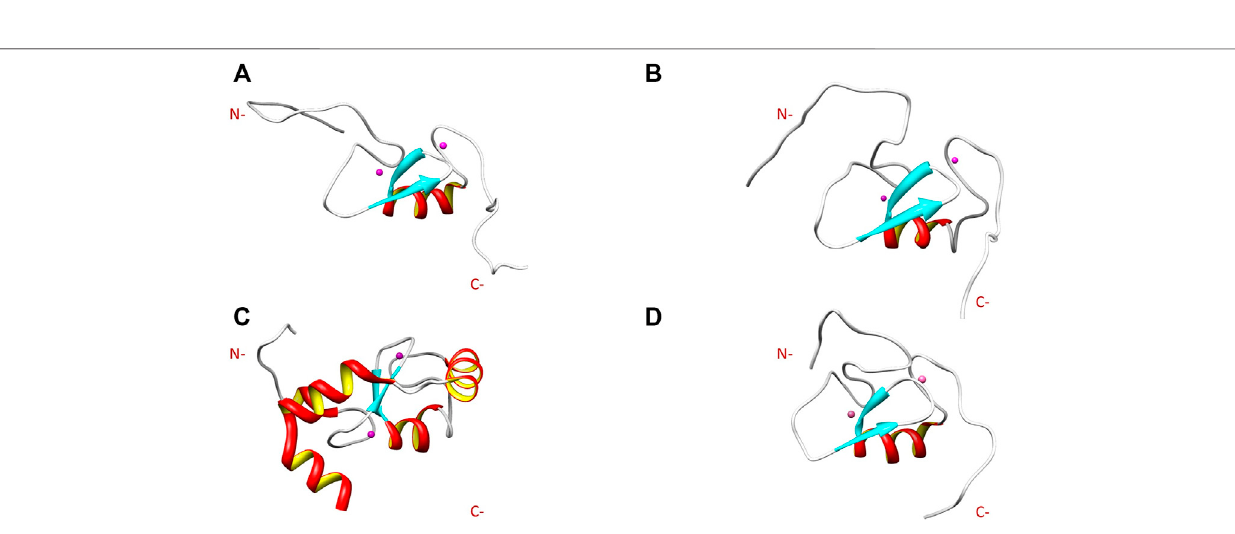
FIGURE 11 | NMR solution structure of (A) RNF24 (PDB: 2EP4), (B) R957C Arkadia, (C) RNF168 (PDB: 4GB0) and (D) wt Arkadia (PDB: 2KIZ) RING domains.